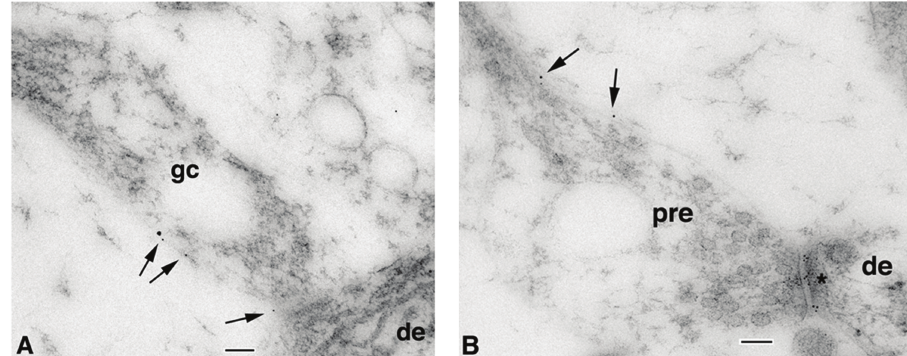
Figure 1: Immunogold localization of NR1 at the surface (5nm gold particles indicated by arrows) of axonal growth cone (A; gc) and subsequent presynaptic terminal contact (B; pre) onto dendrites (de) in the CA1 stratum radiatum (A) or stratum oriens (B) of the postnatal day 2 (P2) hippocampus. Growth cones show characteristic collections of large and small endosomal vesicles. A is an axonal growth cone with a few obscure synaptic vesicles near the presynaptic contact, whereas B shows a better developed synapse, including a presynaptic terminal with numerous, distinct synaptic vesicles and high gold labeling on the postsynaptic membrane (asterisk: also, a clathrin-coated pit/vesicle is evident in the dendrite on the other side of the asterisk). The left part of the presynaptic terminal is expanded into a growth cone structure. Scale bars are 100nm. Reprinted from part of Figure 2 from Wang et al.